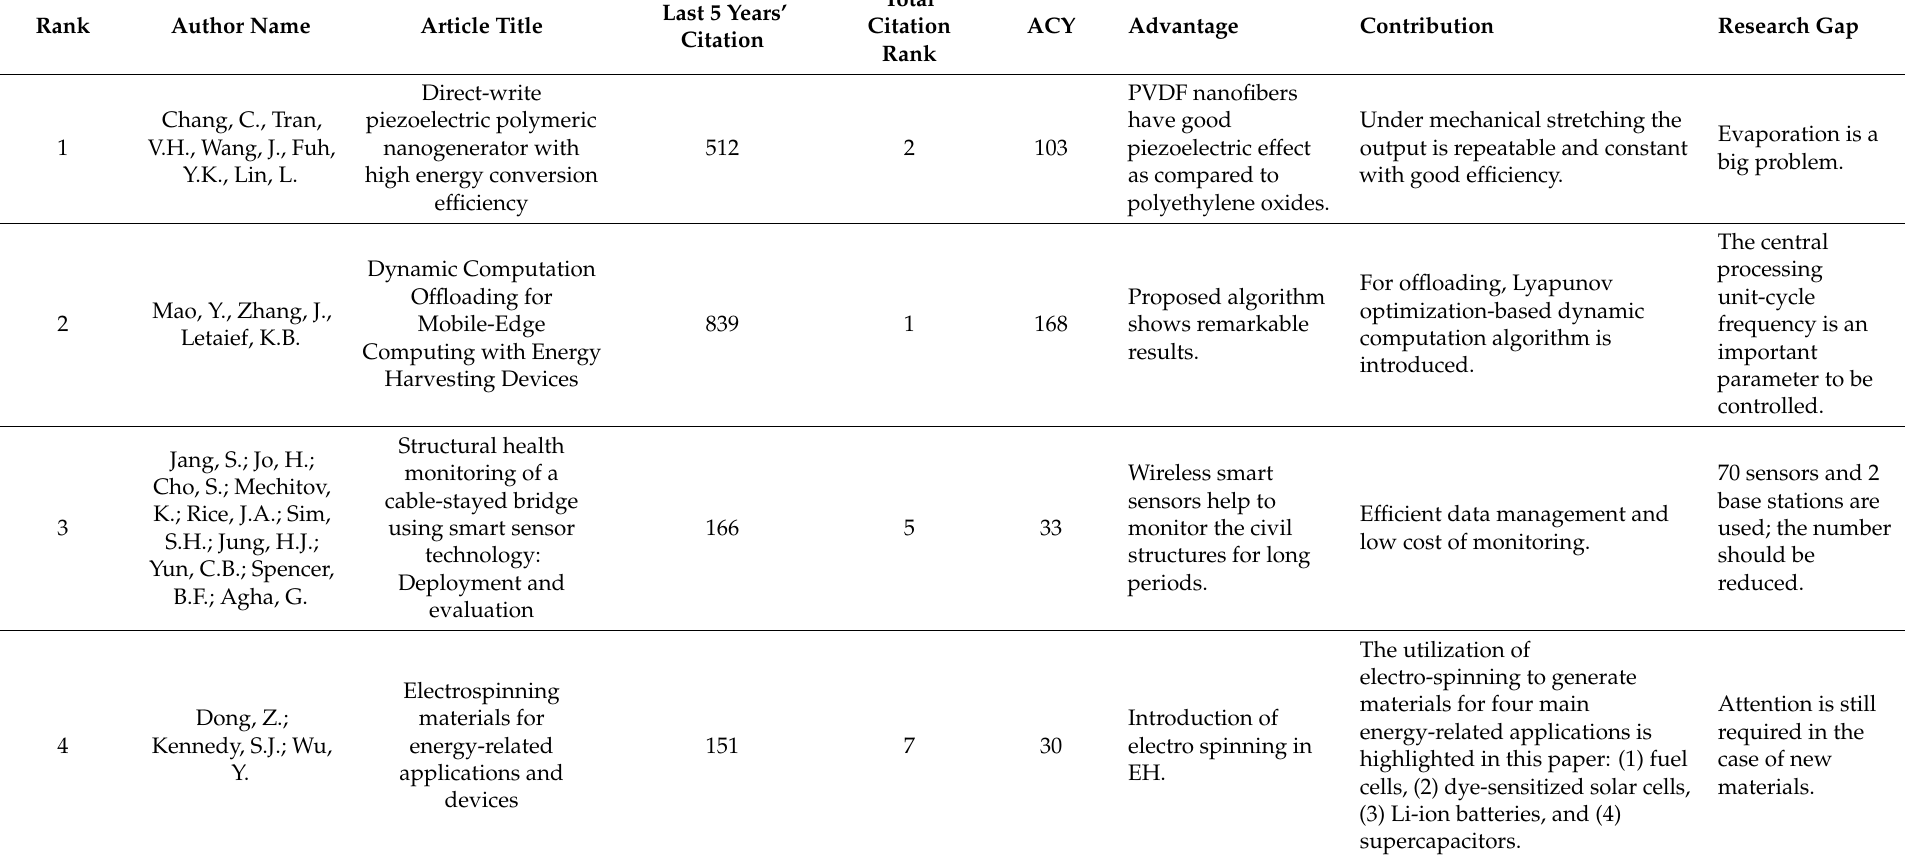
Table 6. Top ten articles based on “highest citation in the last 5 years from 2017 to